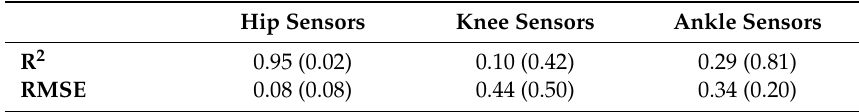
Table 3. The coefficient of determination and root mean squared value of predicted values while using a single joint sensor with standard deviations.